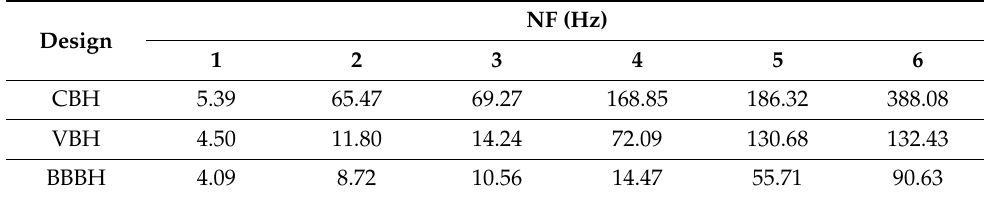
Table 5. First six NFs of each PEH